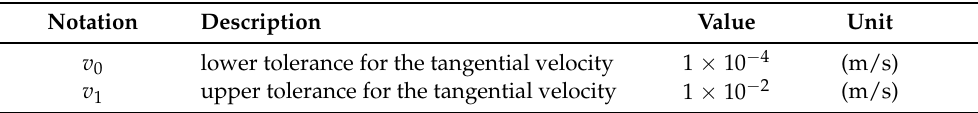
Table 3. Modified Ambrósio friction model